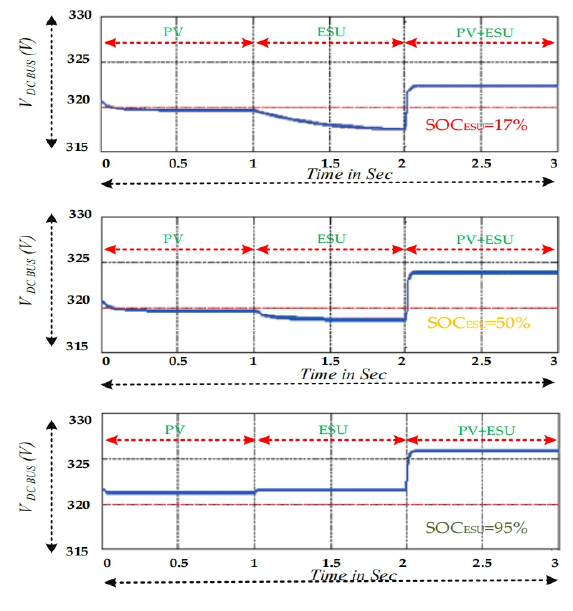
Fig. 5. DC BUS Voltage at different values of SOC of ESU. When the utility grid is overloaded, PV is not producing any output, and the SOC value of PEV is above 98%. PEV supply the power to other PEV, and the corresponding output is shown in Fig. 7a. When PV and ESU values are less than the reference level or not able to give any output, PEV charged from the utility grid, and the corresponding output is shown in Fig.